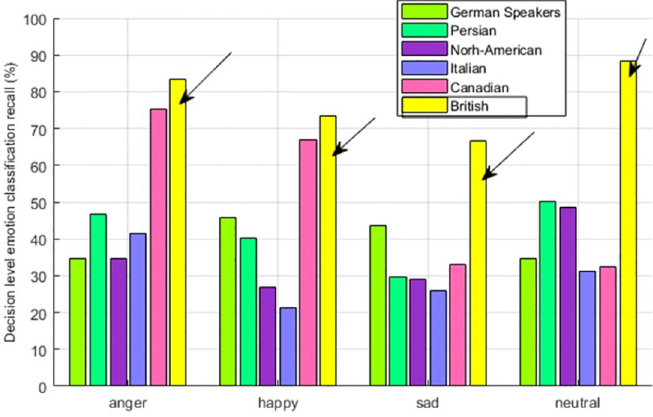
Fig 4. British speaker—Multicultural emotion recall comparison and In-group